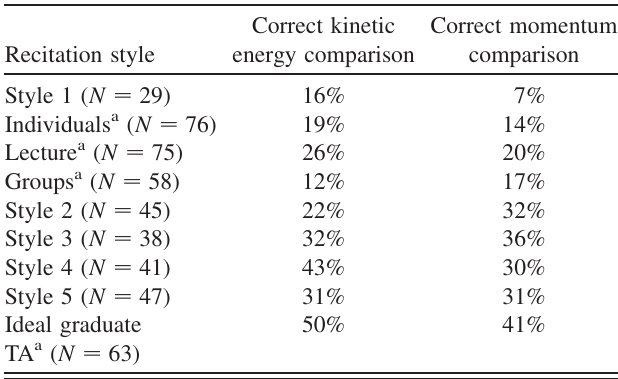
TABLE III. Student performance on post-test for various im- plementation styles.